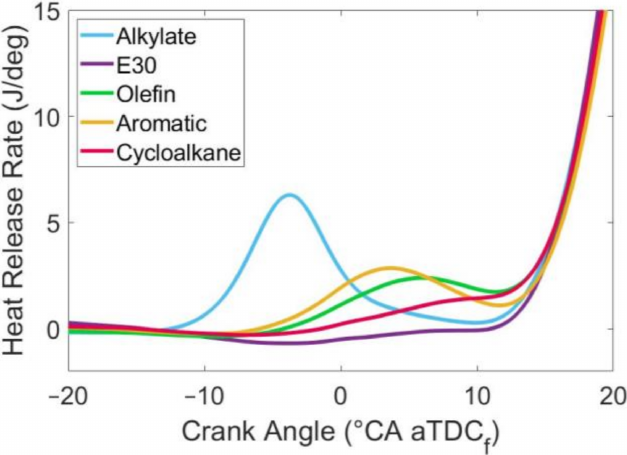
Figure 6. Pre-Spark Heat Release for the Co-Optima fuels for boosted SI